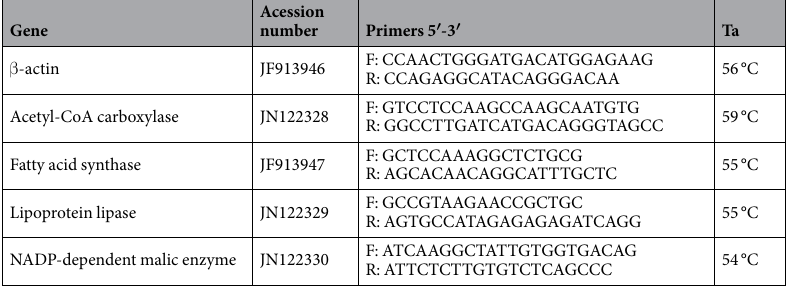
Table 1. List of primers used to determine the enzymatic expression as reported by Lucia et al . 40 . Ta = annealing